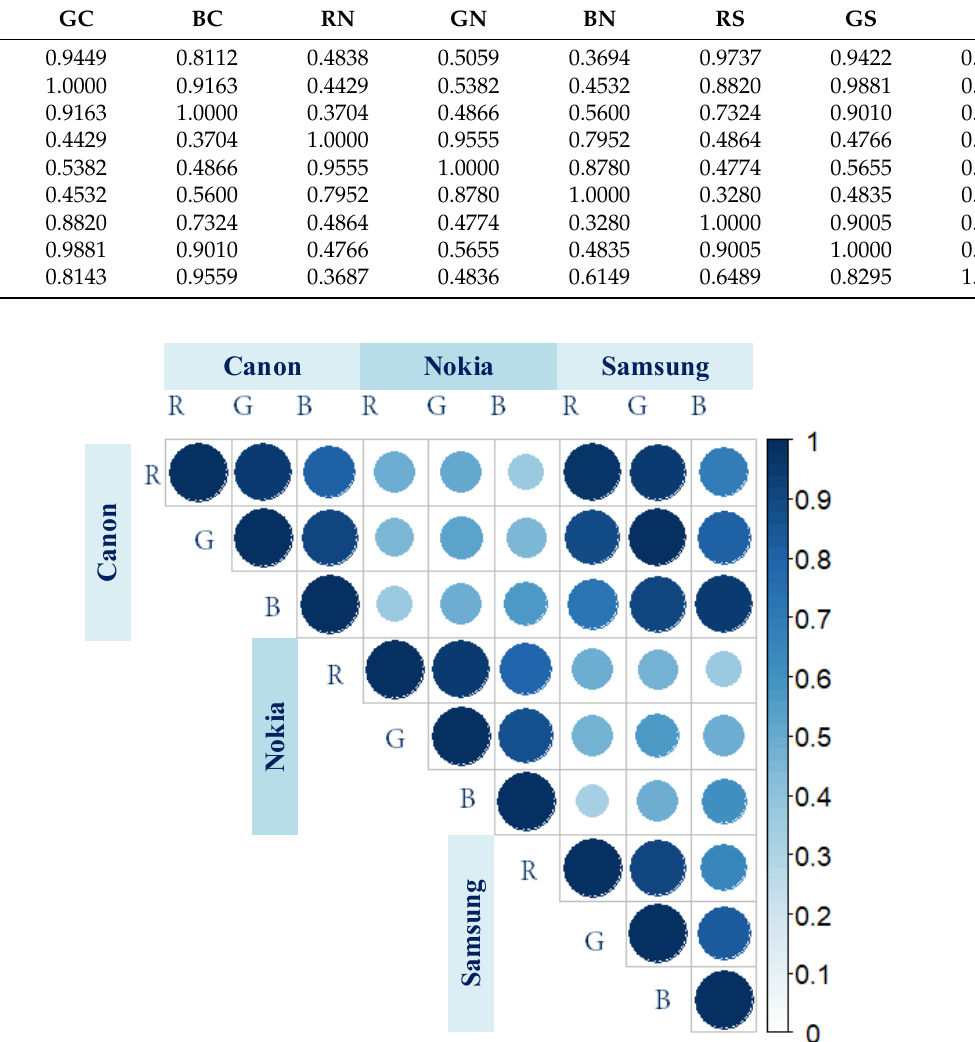
values for Canon, respectively; R N , G N, and B N are the Nokia’s RGB values, respectively; R S , G S and